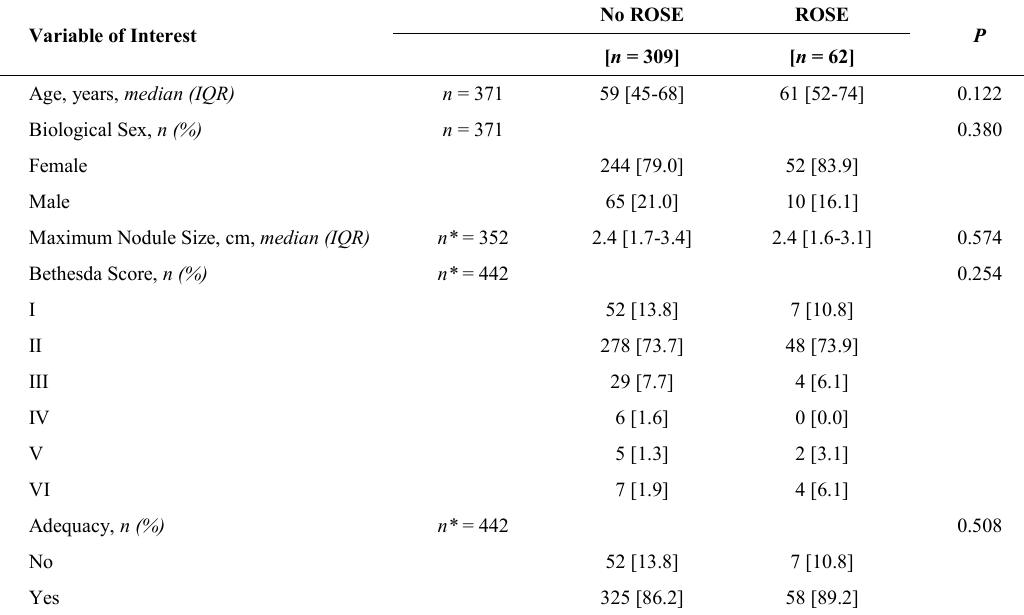
Table 1. Baseline characteristics of patients stratified by presence of rapid onsite